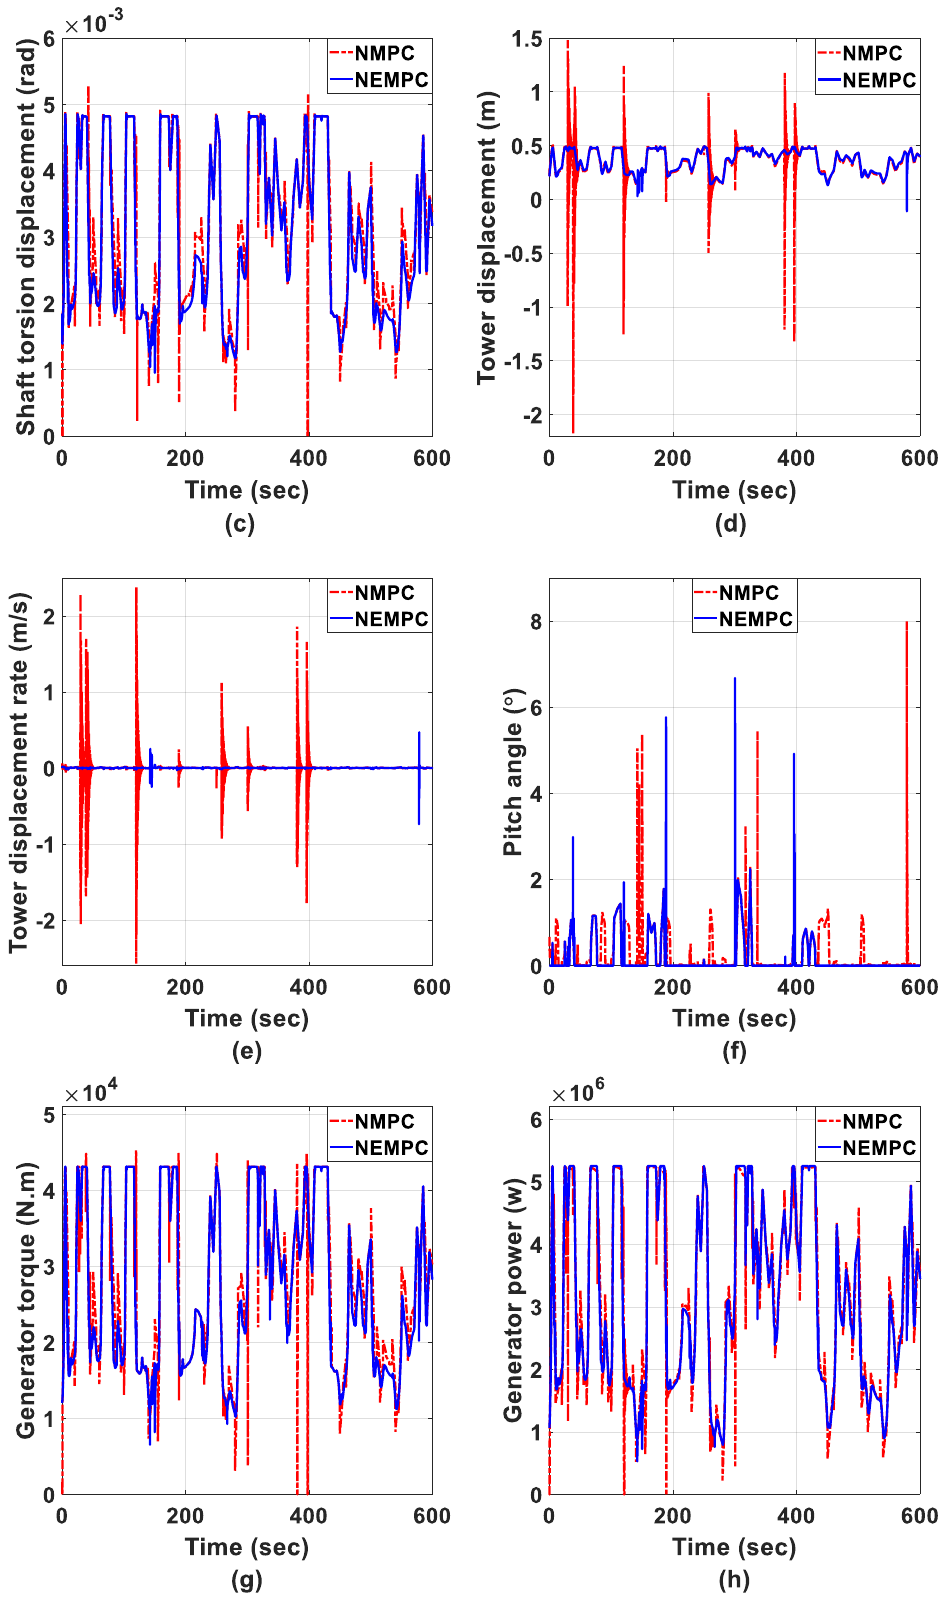
Figure 11. ( a ) Generator speed; ( b ) Rotor speed; ( c ) Shaft torsional angle; ( d ) Tower displacement; ( e ) Tower displacement rate; ( f ) Pitch angle; ( g ) Generator torque; ( h ) Generator power.